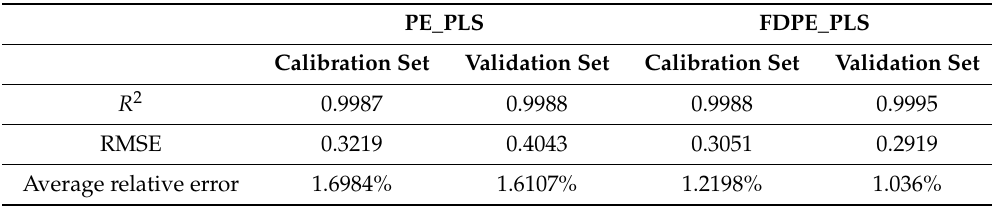
Table 6. The comparation between PE_PLS and FDPE_PLS.